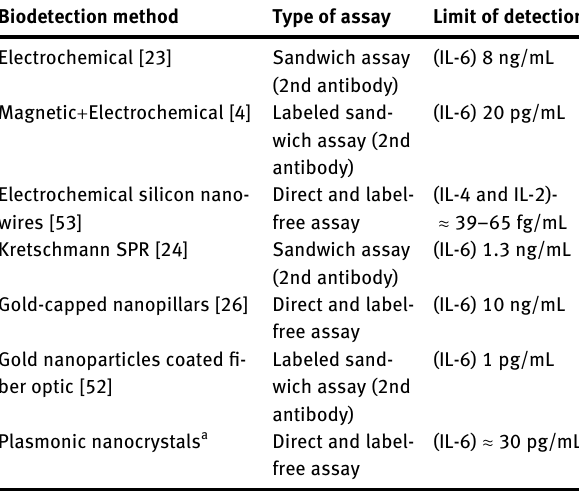
Table  : Comparison of different biosensing technologies for cytokine biodetection in cell culture. Biodetection